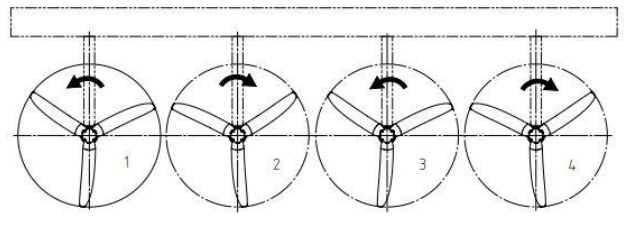
Fig. 3 Schematic SIT 250 configuration on PLAT-I Table I summarizes the properties of the SIT 250 turbine system.